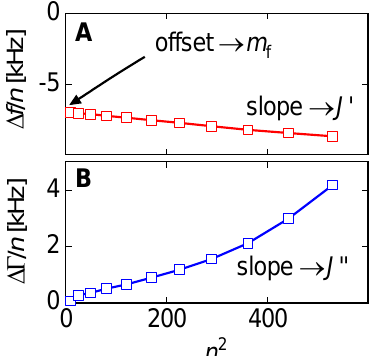
Figure 17. Plots of ∆ f / n and ∆Γ / n versus n 2 as motivated by Equation (46). The film thickness as derived from the offset in panel ( A ) is about 1.6 µ m. The slope d( ∆ f / n )/d( n 2 ) is almost constant, indicating that J f (cid:48) only weakly depends on frequency. There is such a dependence on frequency in ( B ). The data were taken on a spin-cast film of polyisobutylene. Adapted from